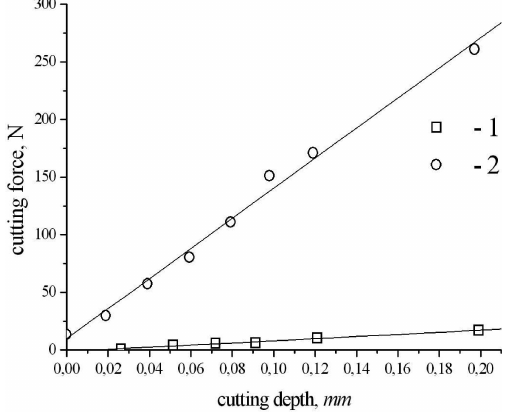
Fig. 1. Effect of depth of cut on cutting force in traditional (1) and vibration-assisted cutting (2) (after